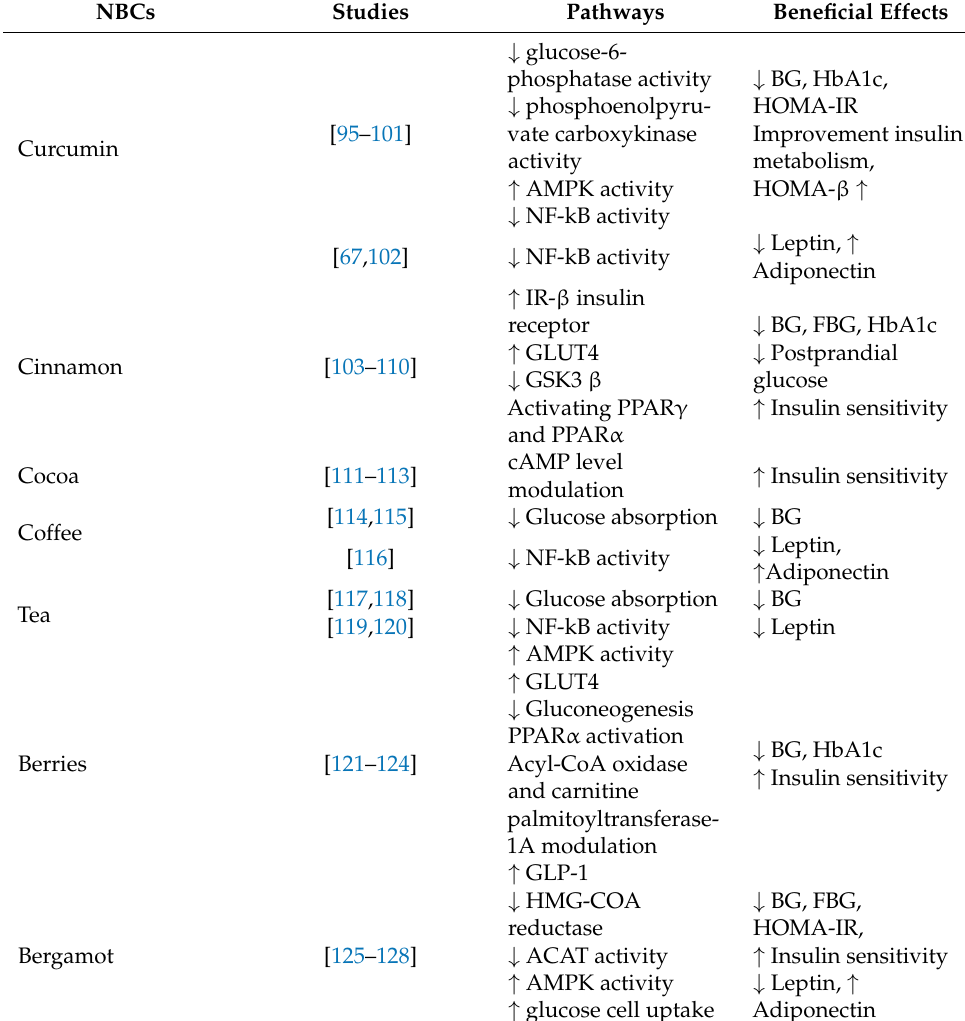
Table 3. NBCs in metabolic alterations